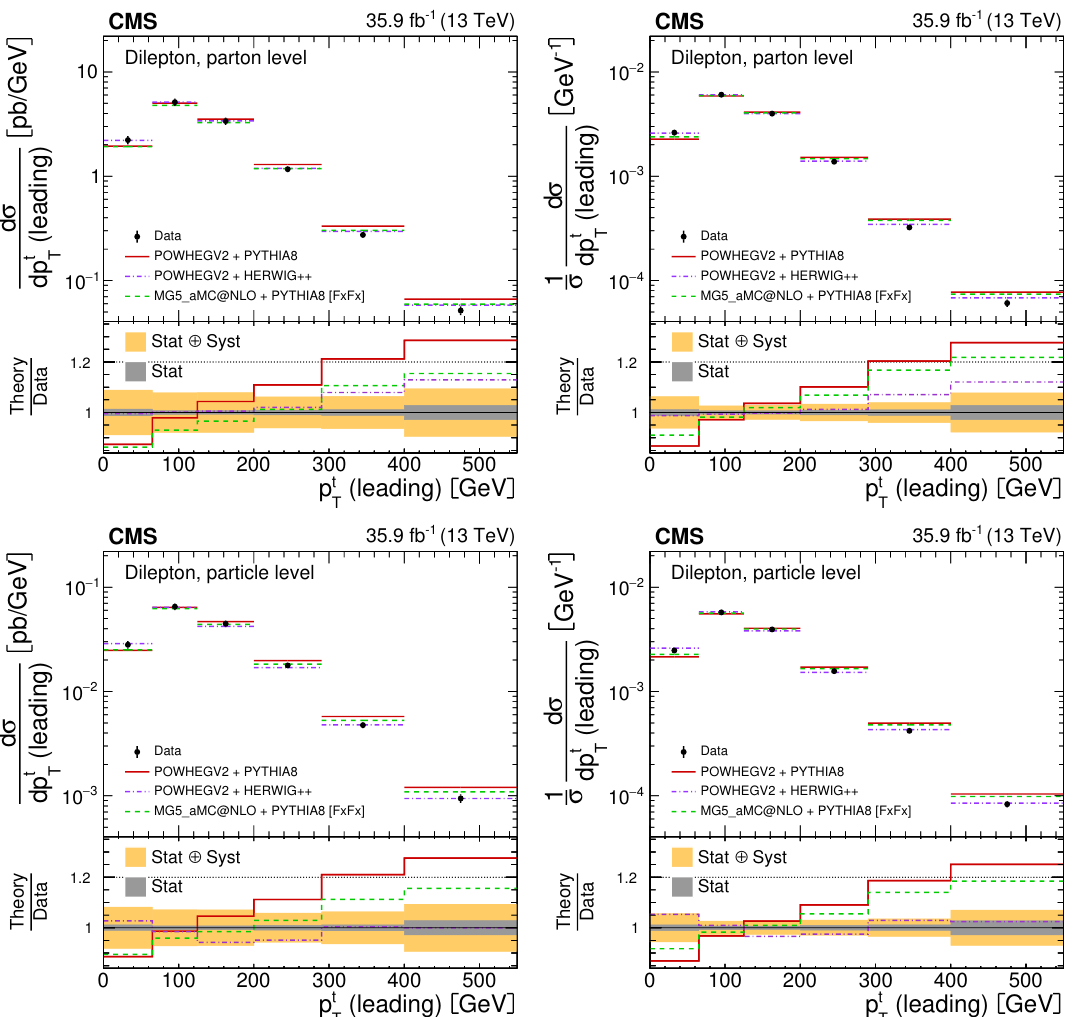
Figure 9 . The di(cid:11)erential tt production cross sections as a function of p t for the data (points) and the MC predictions (lines). The vertical lines on the points indicate the total uncertainty in the data. The left and right columns correspond to absolute and normalised measurements, respectively. The upper row corresponds to measurements at the parton level in the full phase space and the lower row to the particle level in a (cid:12)ducial phase space. The lower panel in each plot shows the ratios of the theoretical predictions to the data. The dark and light bands show the relative statistical and total uncertainties in the data, respectively.